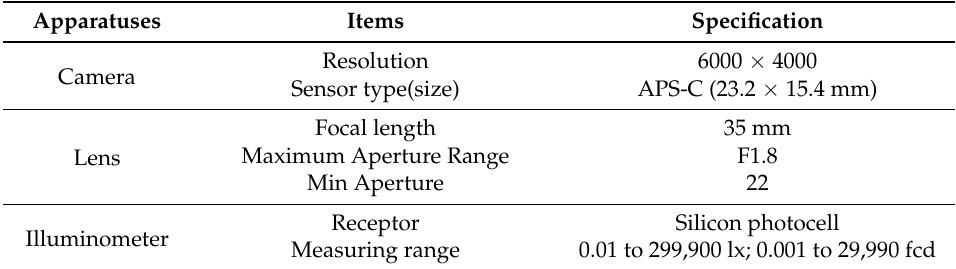
Table 2. Detailed specifications of the apparatuses used in the experiment.